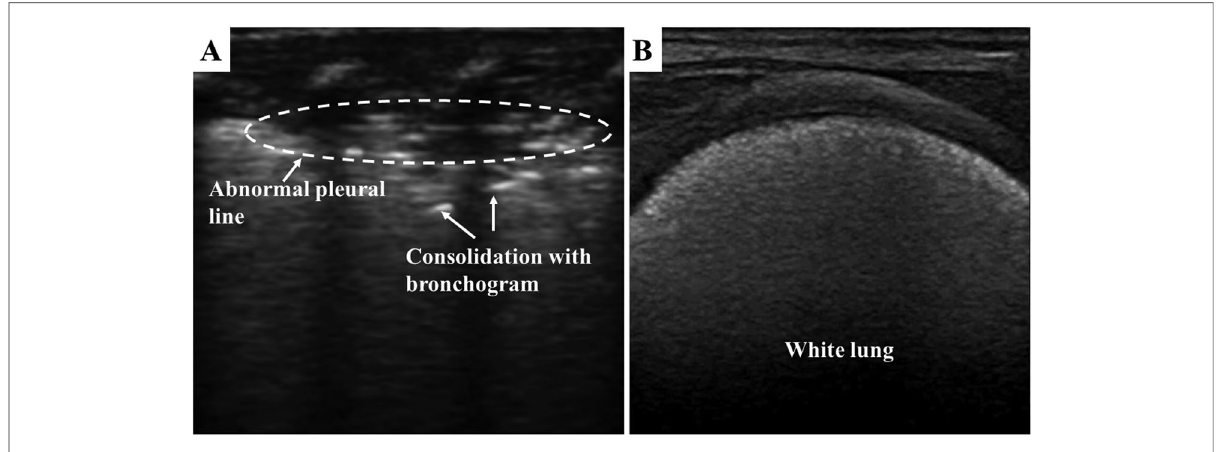
FIGURE 3 Respiratory distress syndrome on lung ultrasonography. ( A ) Pleural line is thick, irregular, or blurred. Lung consolidation with the air bronchogram is the most typical appearance of neonatal RDS. ( B ) white lung is derived from the emerged compact